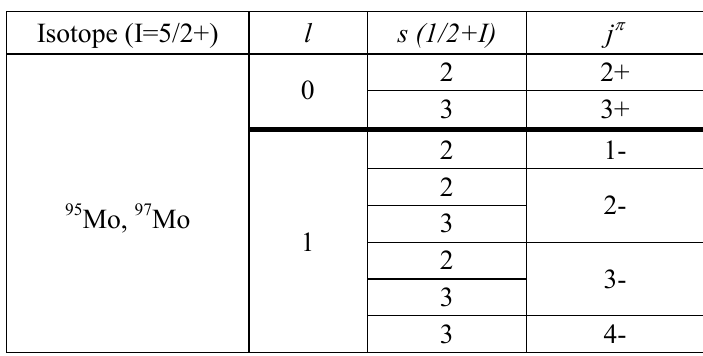
Table IV. Channel spins for molybdenum